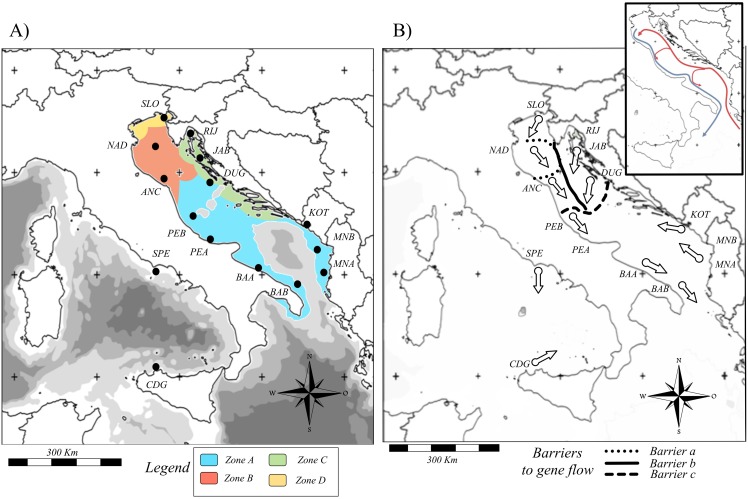
Maps showing sample locations.(a) Map of the Adriatic and Tyrrhenian Seas showing the sampling localities and a general representation of the four main areas described by [17, 18]. (b) Map showing outcomes from the BARRIER [50] and Migrate-n [54]. The three lines (solid, dotted and dashed) represent major barriers to dispersal. The arrows represent the directionality of gene flow from each locality and a map (in the right up corner) of major sea-surface currents allows a direct comparison among them.